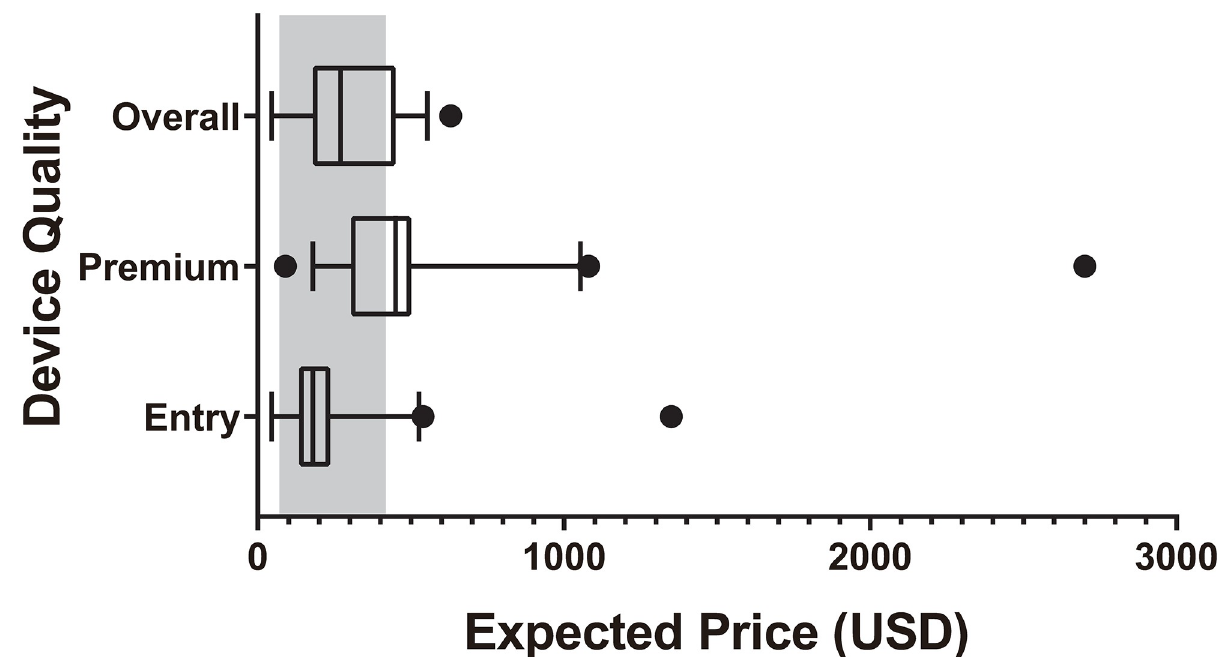
Fig 4. Experts opinion on the price of personal sound amplification products (PSAPs). A box and whisker plot shows summary of a set of data: Maximum, 75 percentile, median, 25 percentile and minimum. Grey area indicates real market price of PSAPs. US $, United States dollar.